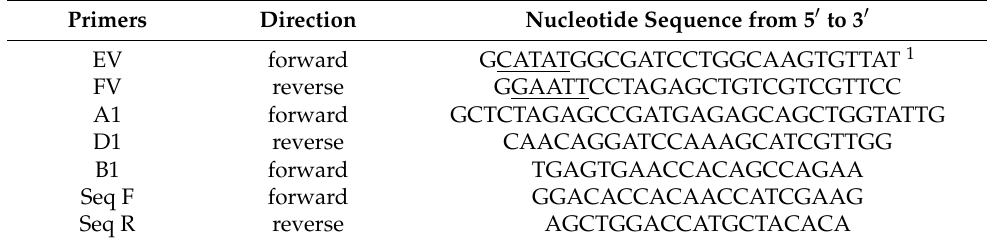
Table 2. Oligonucleotide